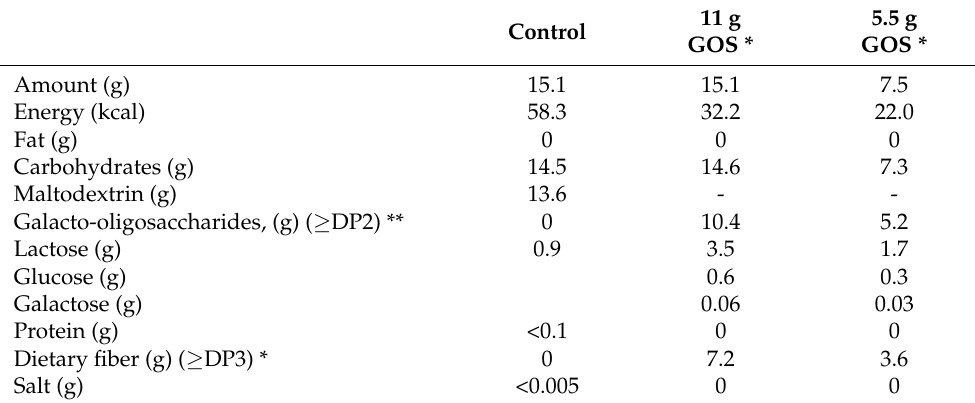
Table 1. Nutrient composition of the study products (per sachet, daily